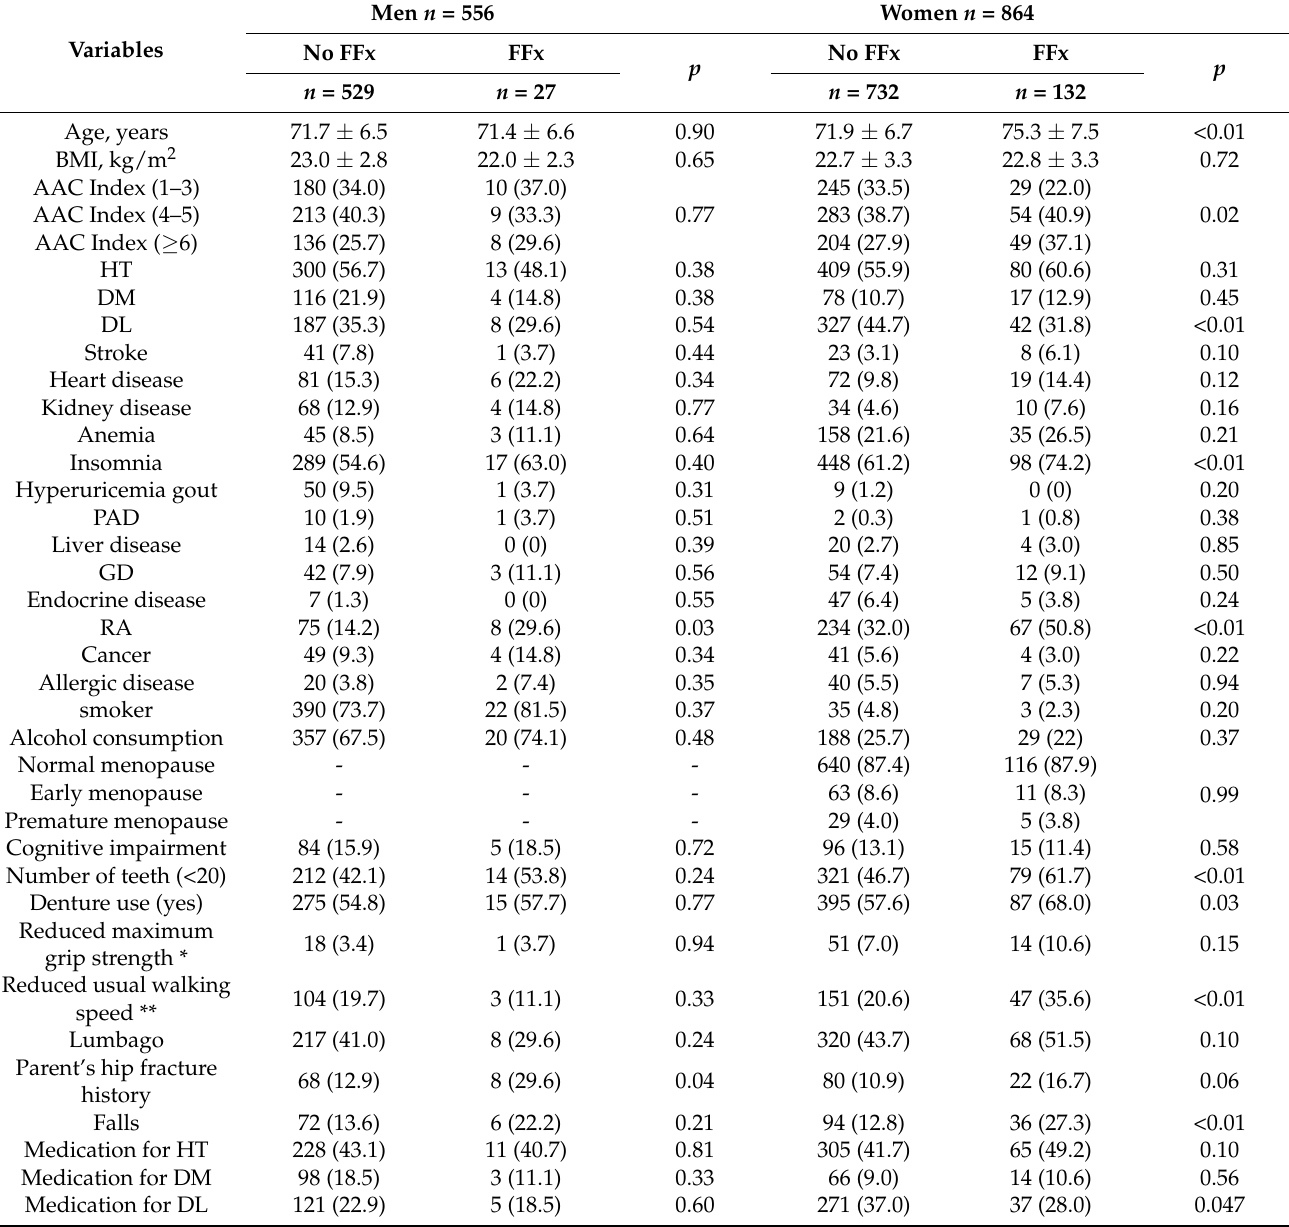
Table 1. Characteristics of study participants according to fragility fracture during the last five years in men and women.